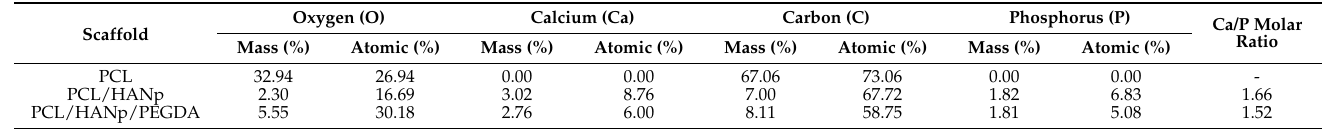
Table 2. EDX analysis of the scaffolds produced and CA/P molar ratio results.